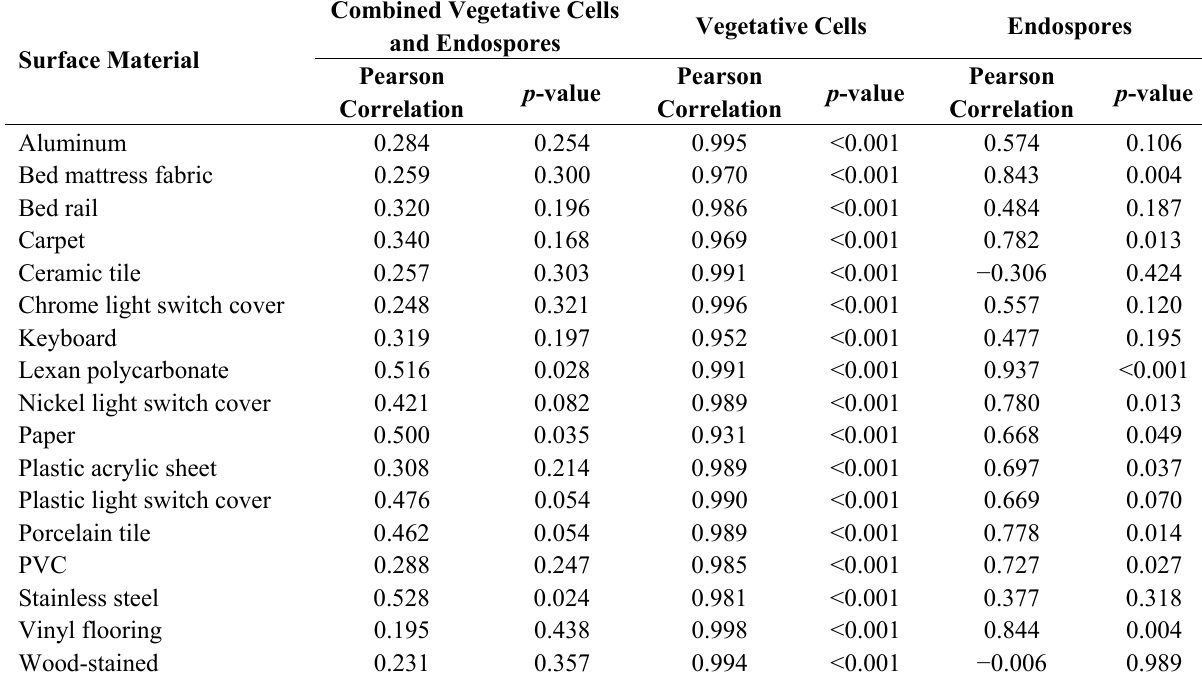
Table 4. Correlations between RLU and CFU on individual